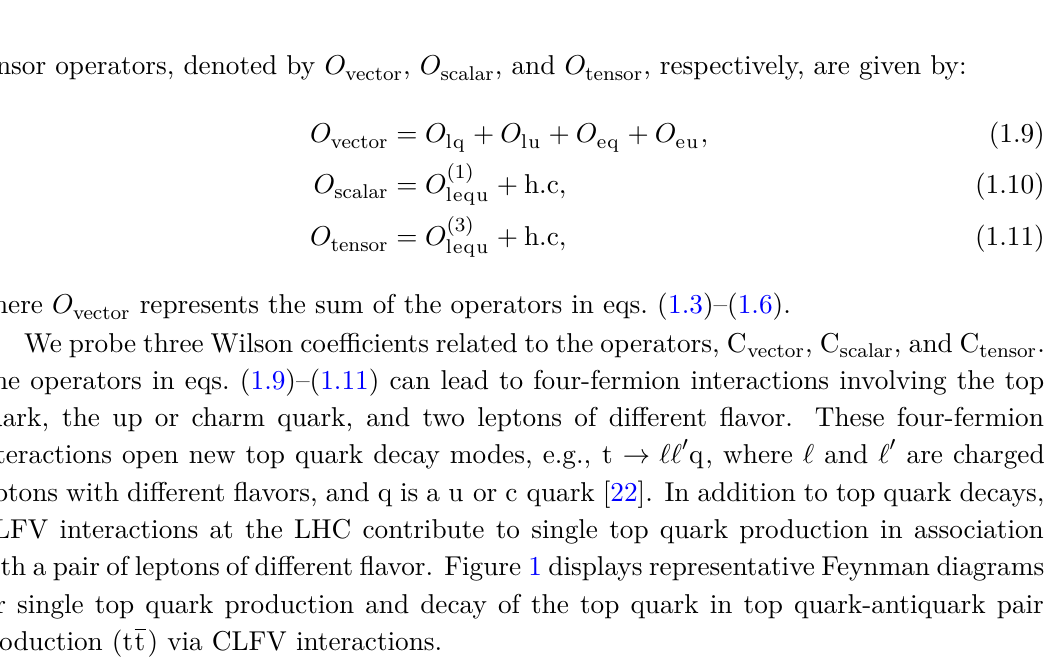
Figure 1 . Feynman diagrams for single top quark production (left and middle) and top quark decays in SM tt events (right) via CLFV interactions. The CLFV vertex is marked as a filled